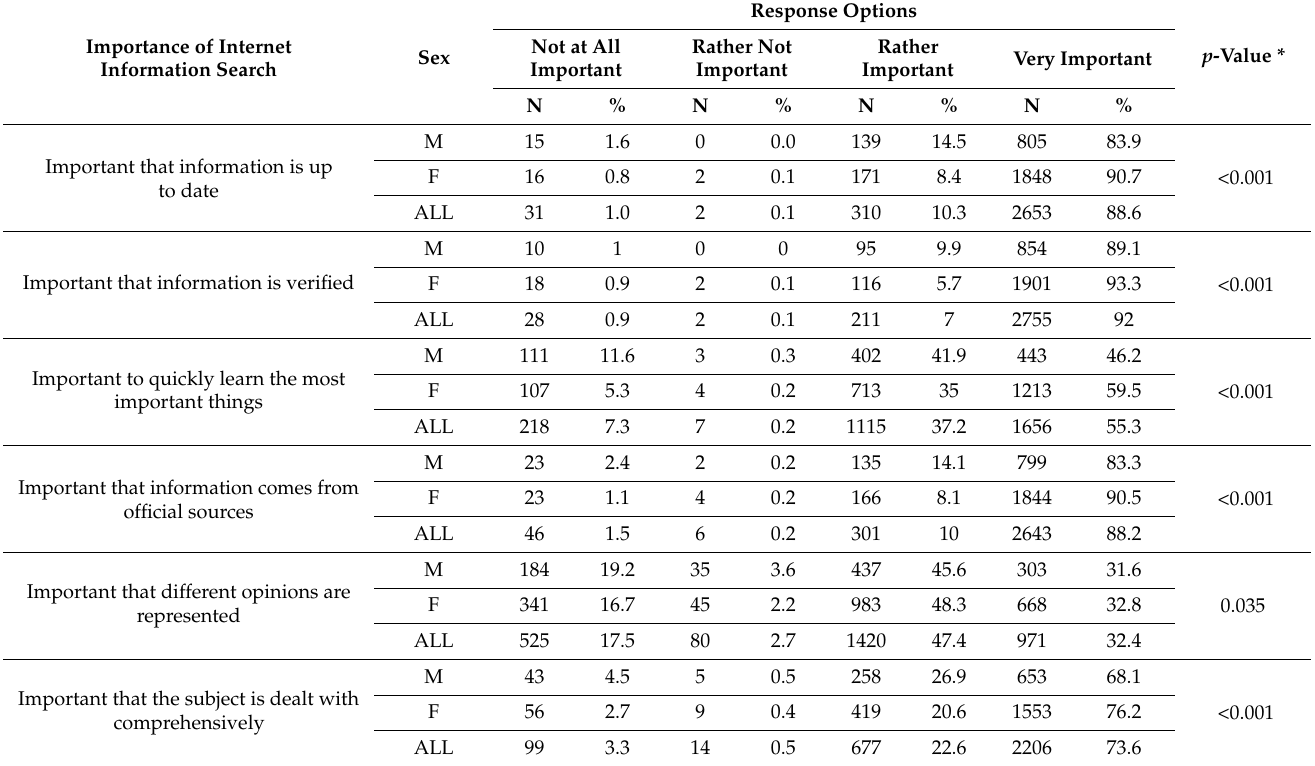
Table 3. Descriptive analysis of the importance of an Internet information search ( N =